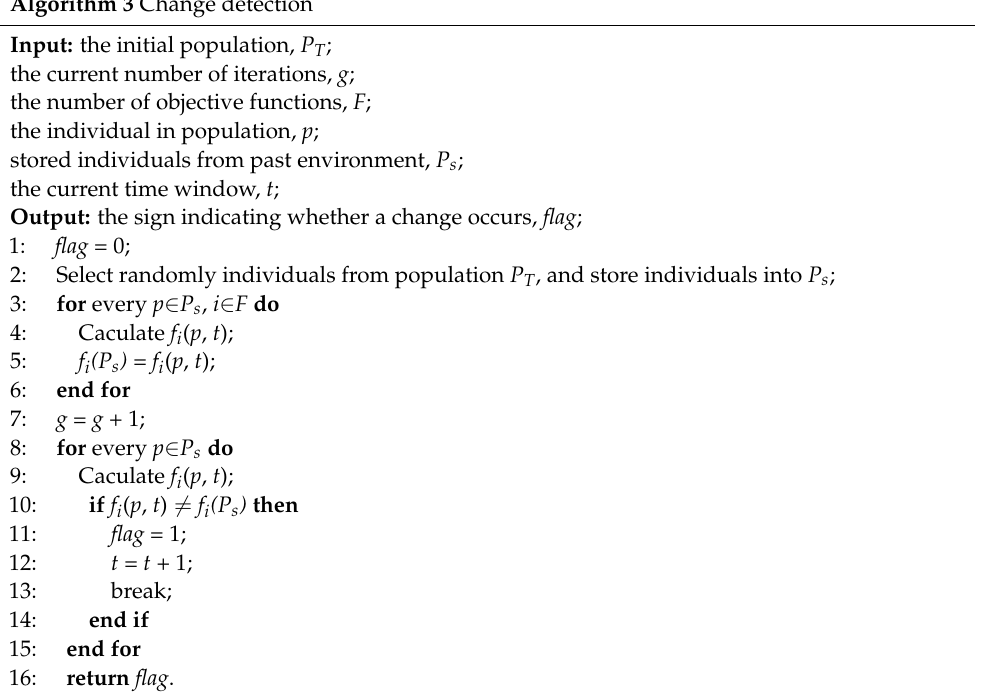
Algorithm 3 Change